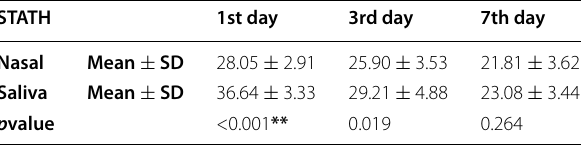
STATH Statherin, SD Standard deviation